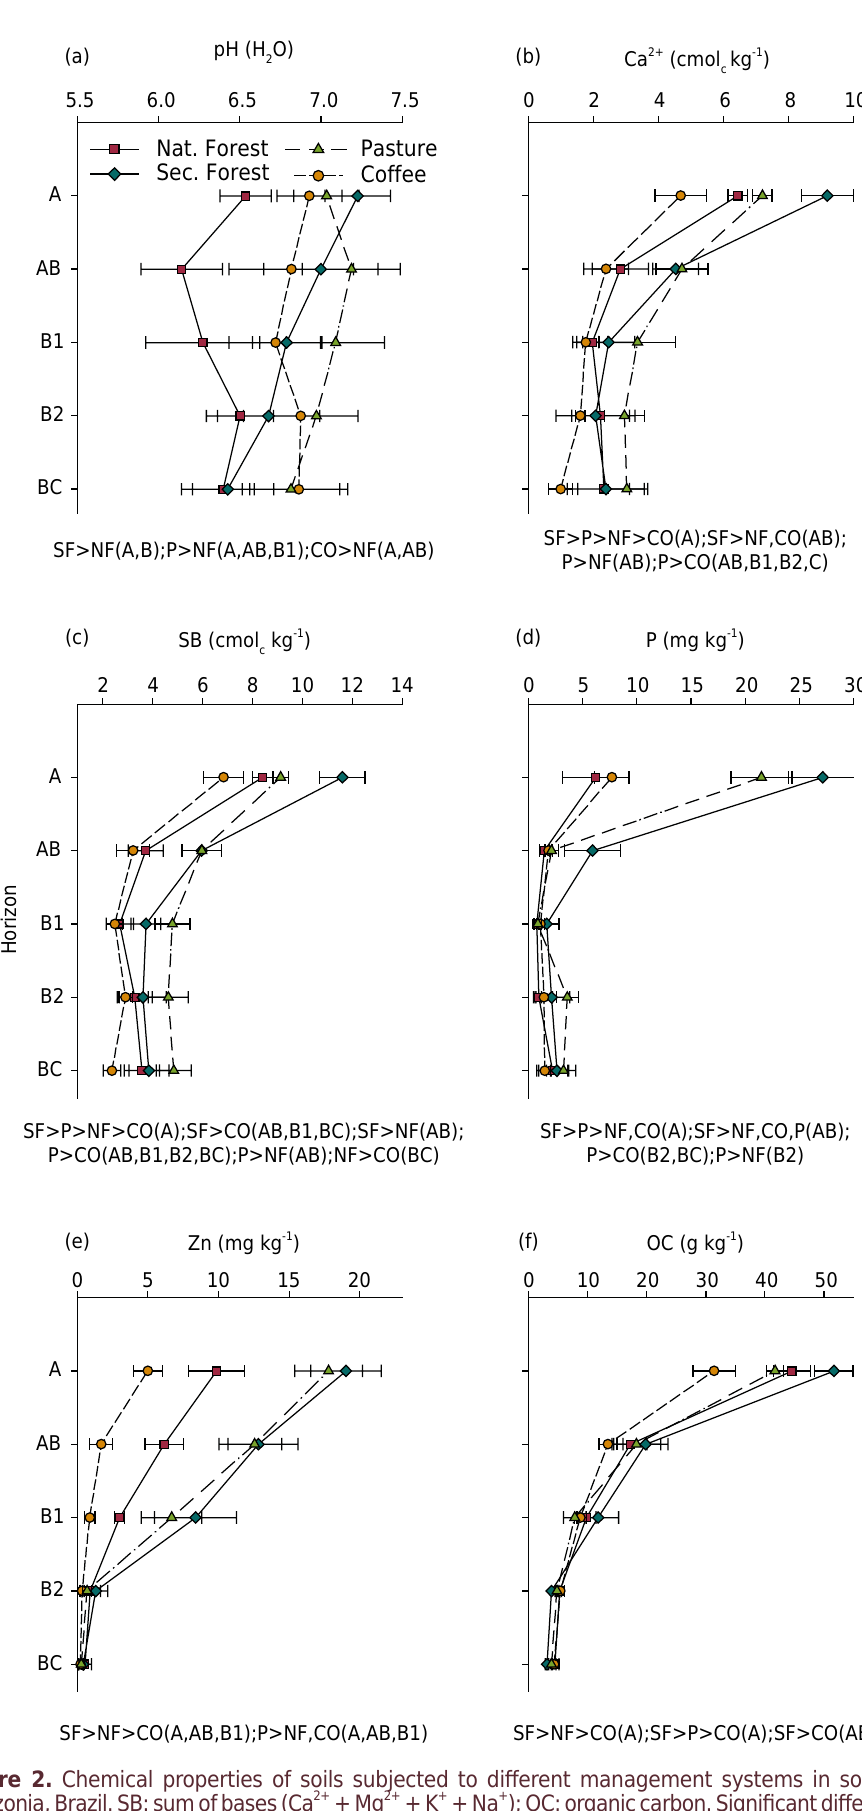
Figure 2. Chemical properties of soils subjected to different management systems in southern Amazonia, Brazil. SB: sum of bases (Ca 2+ + Mg 2+ + K + + Na + ); OC: organic carbon. Significant differences are highlighted on the line above each figure. Standard deviation is represented in horizontal